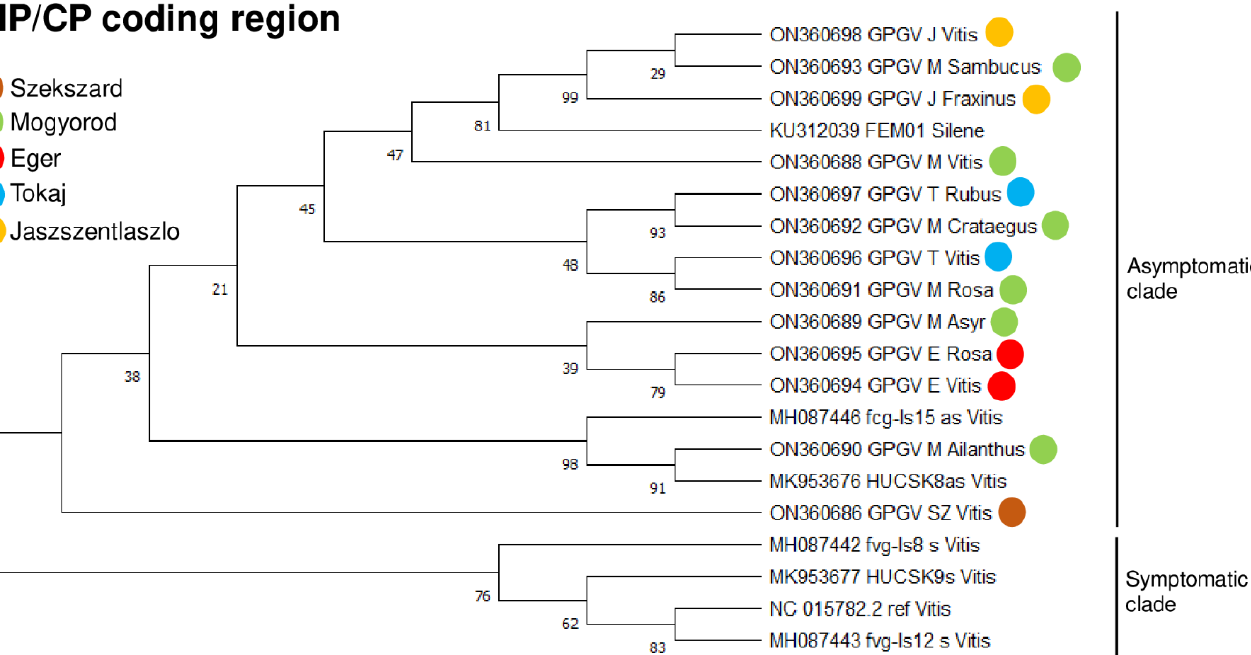
Figure 5 . Evolutionary analysis of 5 ′ nucleotide region of GPGV genome by the maximum likelihood method. Evolutionary history was inferred by using the maximum likelihood method and the Tamura–Nei model. Bootstrap consensus tree inferred from 1000 replicates is taken to represent evolutionary history of analyzed taxa. Branches corresponding to partitions reproduced in less than 50% bootstrap replicates are collapsed. Percentage of replicate trees in which associated taxa clus-